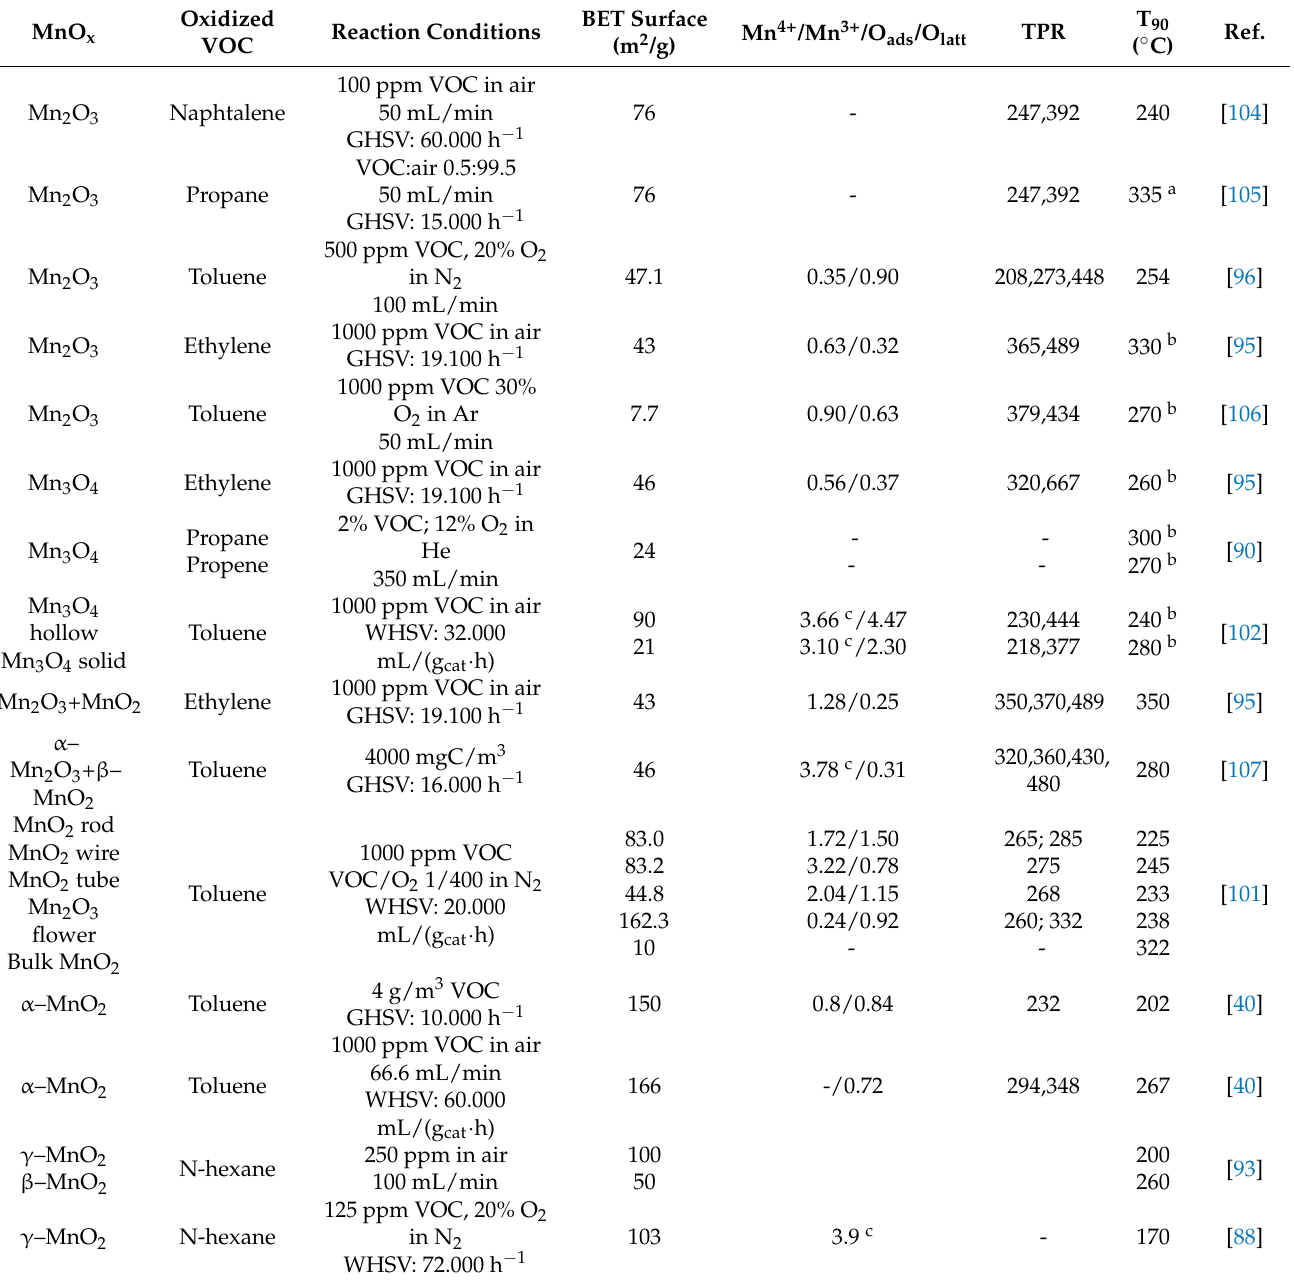
Table 2. Oxidation of hydrocarbons over single manganese